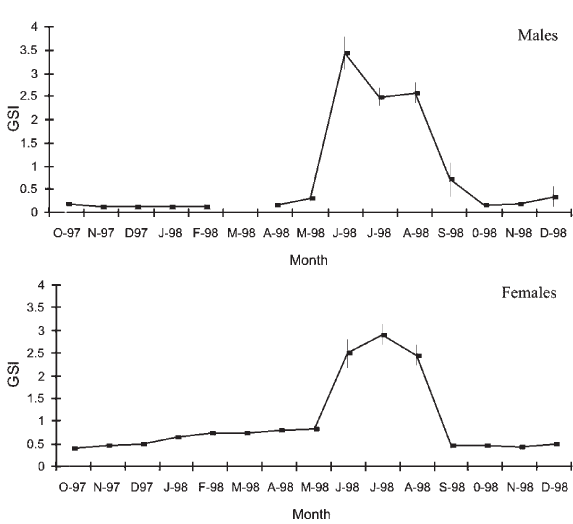
F IG . 9. – Monthly variation of the gonadosomatic index (GSI) for males and females of L. mormyrus in the Thracian Sea coastal area. Vertical bars represent ± 1 standard